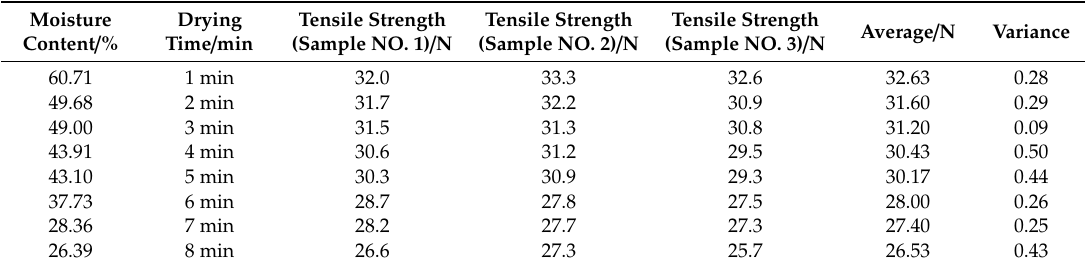
Table 3. Tensile properties of blade root at two points under di ff erent moisture